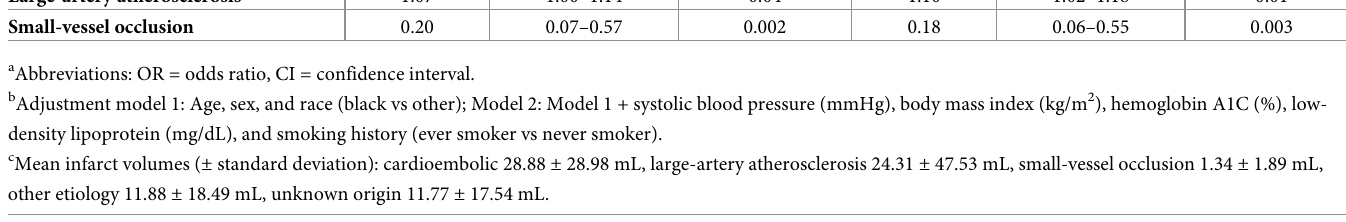
Table 3. Multinomial logistic regression demonstrating the adjusted relative risk ratio (RRR) of each specified stroke subtype (reference: cardioembolic) per 5 mL increase in ischemic stroke infarct volume (N = 150).